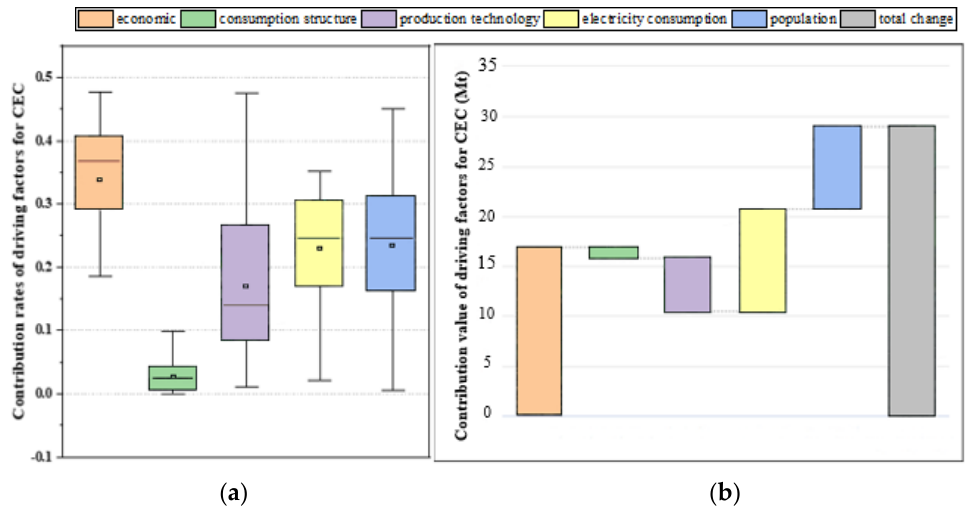
Figure 8. Contribution rates and contribution value of driving factors for CEC. ( a ) Contribution rates of driving factors for CEC. ( b ) Contribution value of driving factors for CEC.